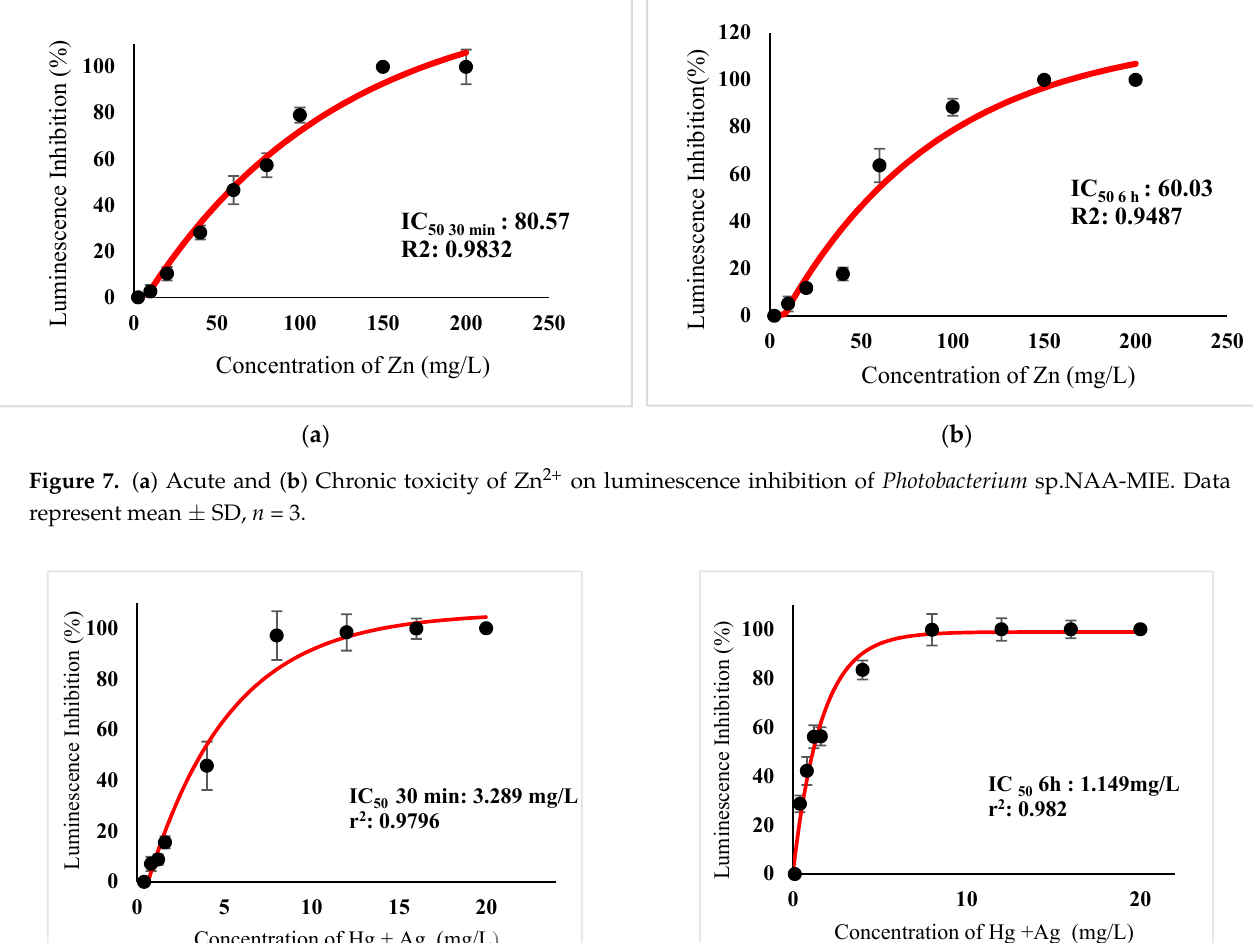
Figure 6. ( a ) Acute and ( b ) Chronic toxicity of Ni 2+ on luminescence inhibition of Photobacterium sp.NAA-MIE. Data repre- sent mean ± SD, n = 3.